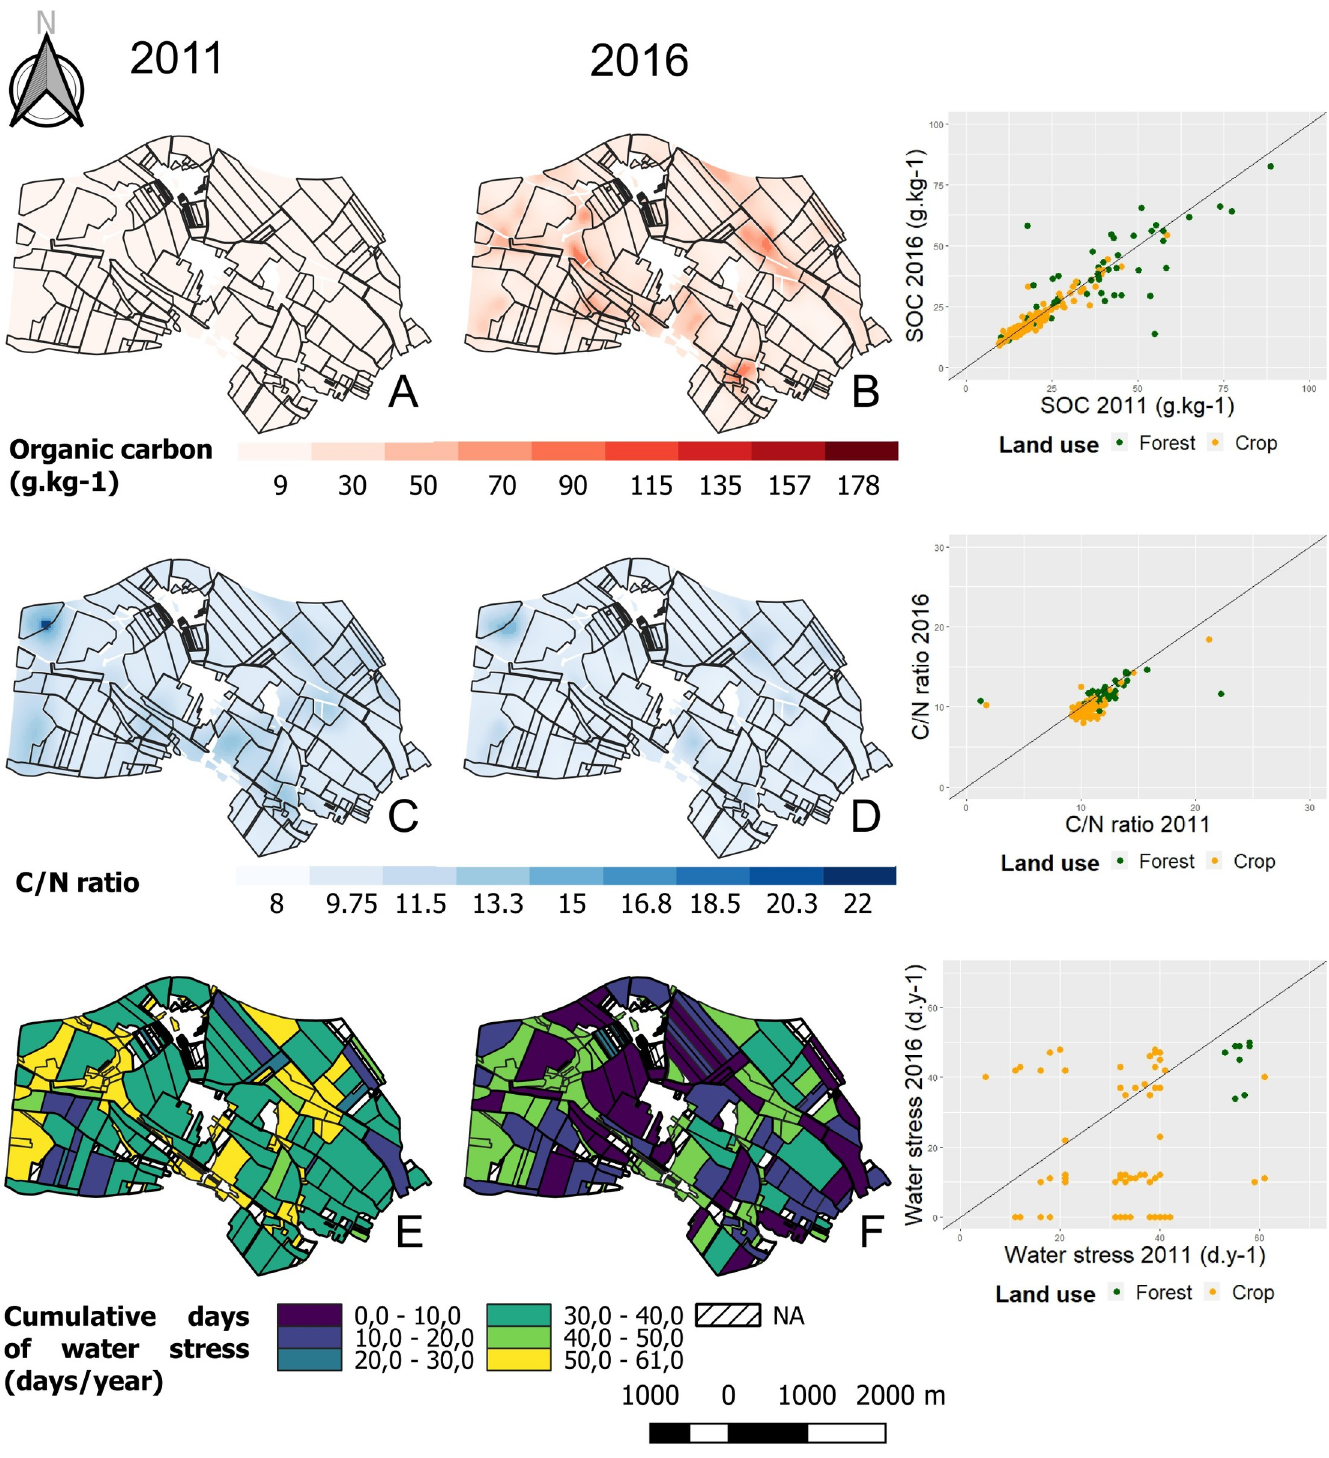
Fig 3. Interpolated mapping of the soil variables organic carbon (A, B), C:N ratio (C, D) and cumulative days of water stress (E, F) for the 2011 sampling campaign (A, C, E) and the 2016 campaign (B, D, F). The Mate´rn model was used to fit the experimental variogram. The ranges of the models were A: 144.33 m; B: 126.70 m; C: 126.24 m; D: 114.63 m. The estimated water stress in the topsoil is represented at the plot scale. Scatter plots on the right of the figure correspond to the variation of the parameter in 2016 depending on the same parameter in 2011. Green dots, forest plots; orange dots, farmed plots. Plot lines, equation y = x.